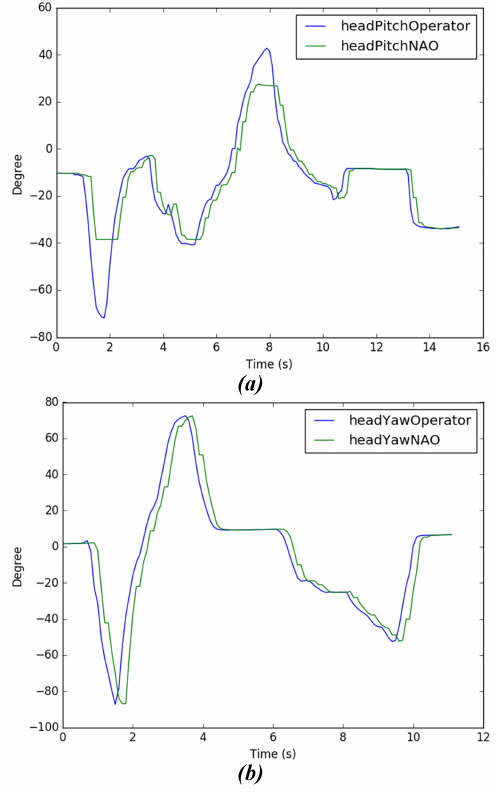
Figure 21. Result of head following experiment for both human and NAO robot. ( a ) Head pitch motion ( b ) Head Yaw motion.